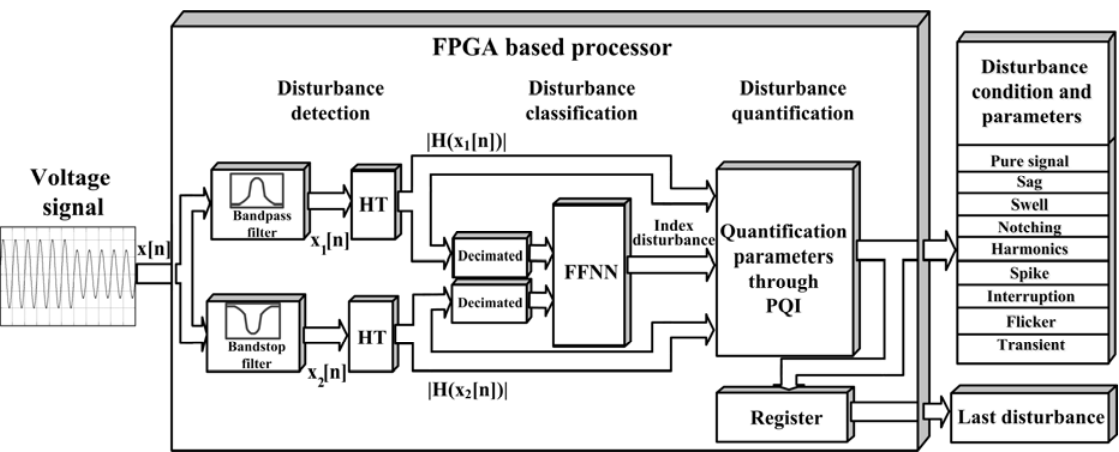
Figure 4. FPGA-based